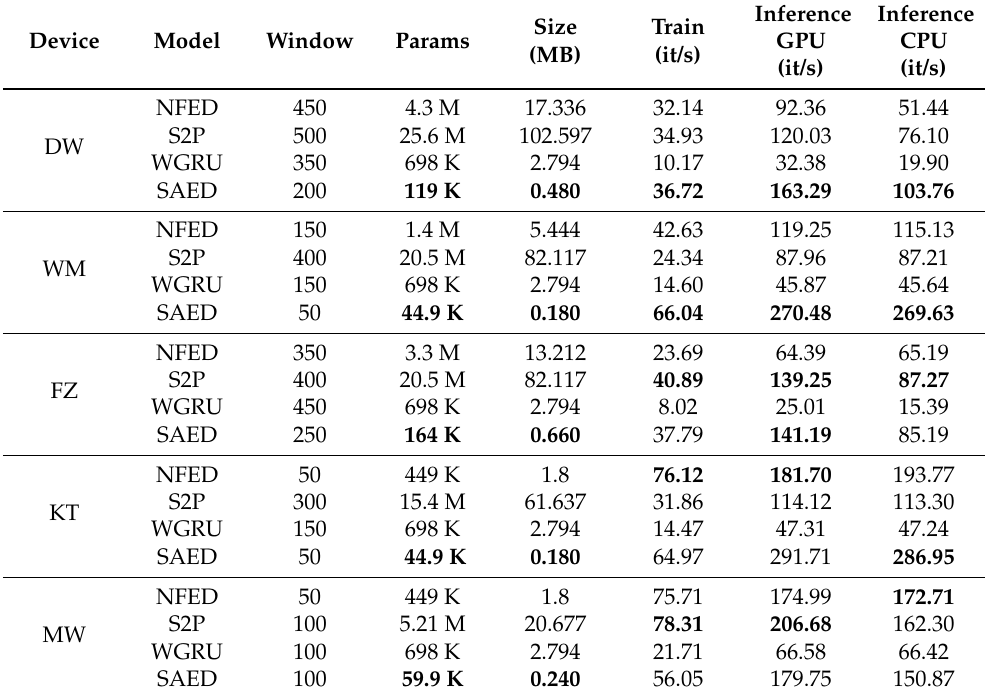
Table 4. Properties of the tested models for each appliance. Number of parameters, size of the model per device, training speed (GPU), inference speed (GPU and CPU).